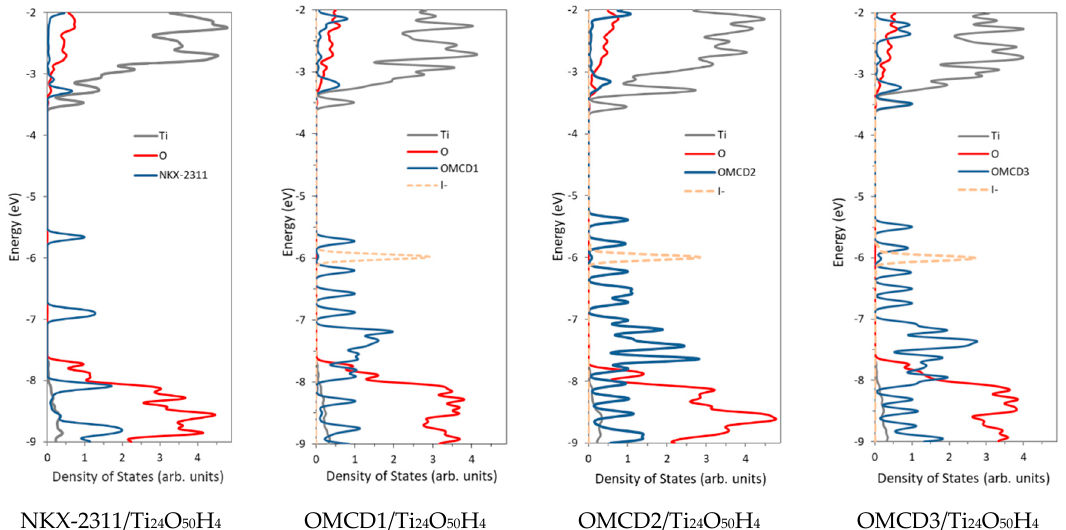
Figure 7. Density of states of the dye-oxide systems calculated in ethanol at the DFT / B3LYP / DZVP level. The contributions of the various atoms are: Ti—grey, O—red, dye molecules—blue, I—-orange. Energy levels were convoluted with Gaussian distributions with full width at half maximum 0.1